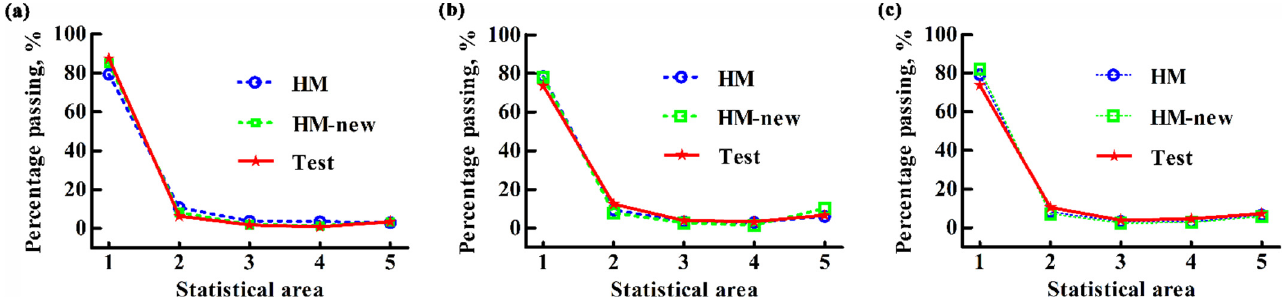
Figure 24. Comparisons between the simulation results and the test results of the percentage of particle numbers in different statistical areas for soybean particles of ( a ) S-42, ( b ) J-17, and ( c ) Z-39.